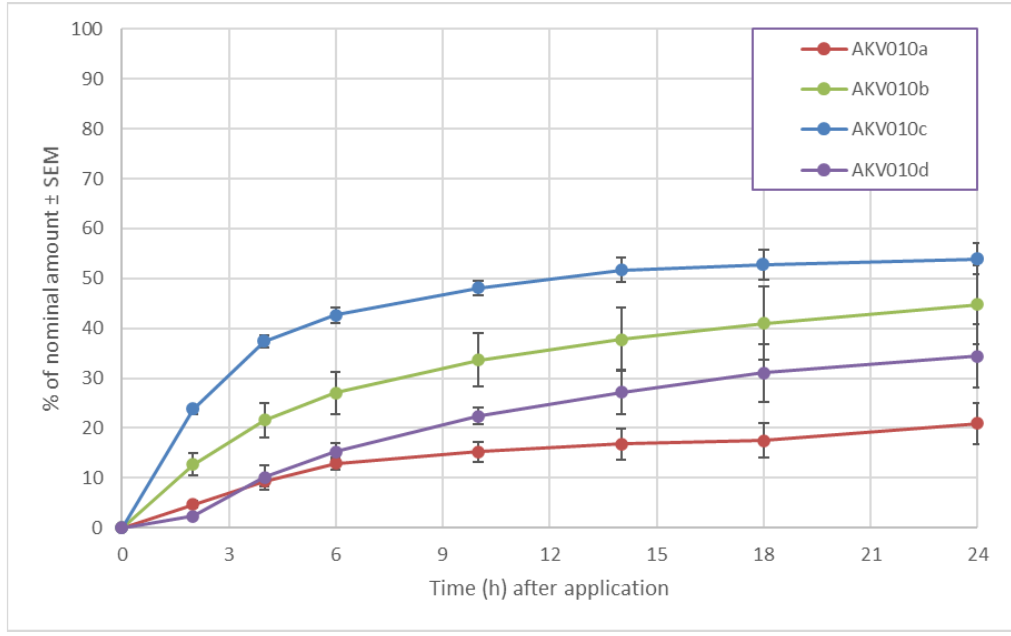
Figure 11. Cumulative permeation of diclofenac sodium through Strat-M membranes.